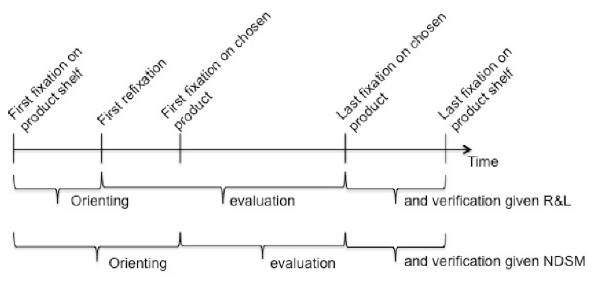
Figure 1. The decision